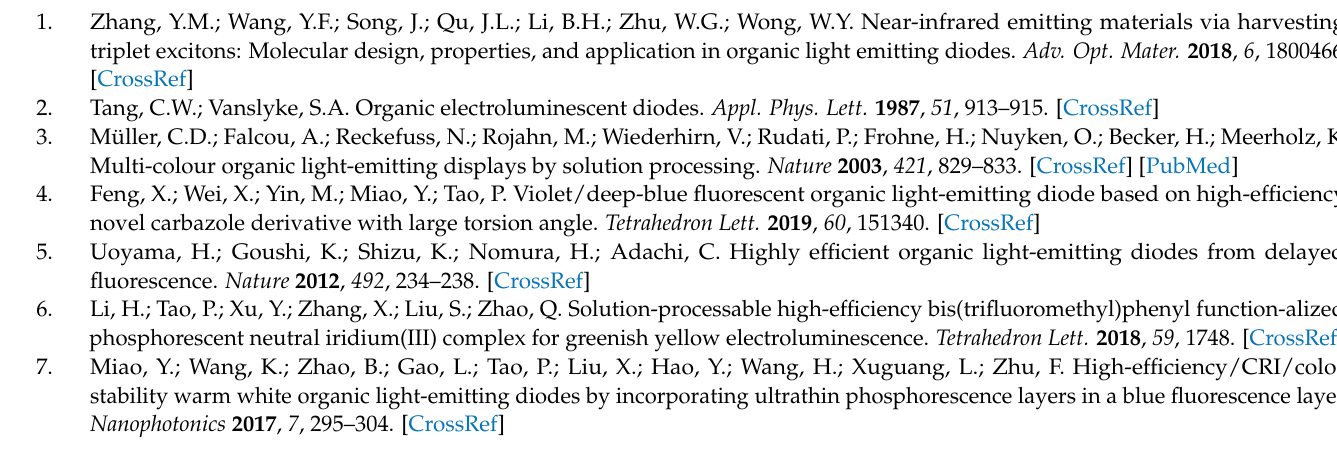
Figure S6: The emission spectra of Ir1 and Ir2 at different